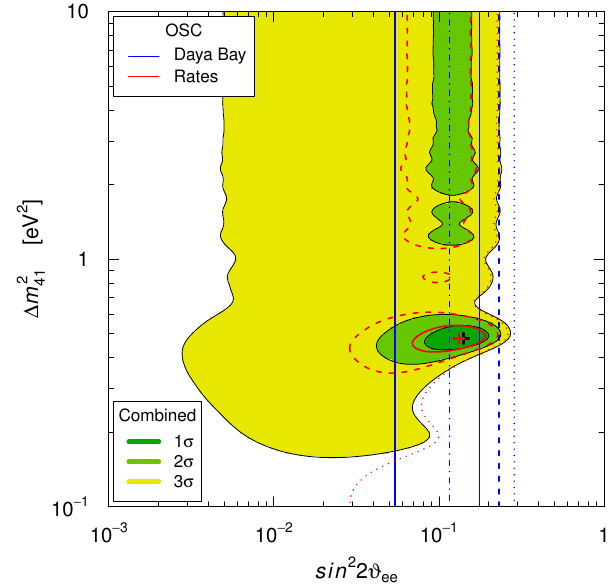
Figure 4 . Allowed regions in the sin 2 2 # ee {(cid:1) m 2 plane obtained from the (cid:12)t of the Daya Bay 41 evolution data [11] (Daya Bay), from the (cid:12)t of the reactor rates (Rates), and from the combined (cid:12)t (Combined) with the OSC model. The best (cid:12)t points are indicated by crosses, except for the (cid:12)t of the Daya Bay evolution data for which the best (cid:12)t is the vertical dash-dotted line. For the Daya Bay and Rates (cid:12)ts the 1 (cid:27) , 2 (cid:27) , and 3 (cid:27) allowed regions are limited, respectively, by solid, dashed, and dotted